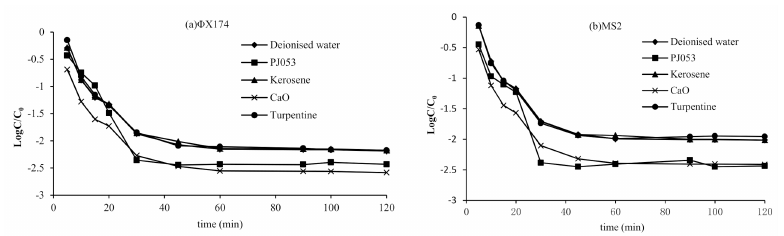
Figure 6. Effect of flotation reagents on the adsorption of ( a ) Φ X174 and ( b ) MS2 (expressed as logC/C 0